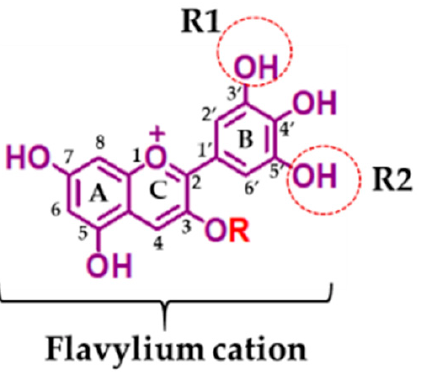
Figure 1. Chemical representation of delphinidin and its glycosides. R = H (delphinidin), R = glucoside (delphinidin-3- O -glucoside), R = galactoside (delphinidin-3- O -galactoside), R = rutinoside (delphinidin-3- O -rutinoside), R = arabinoside, (delphinidin-3- O -arabinoside), and R = sambubioside (delphinidin-3- O -sambubioside).